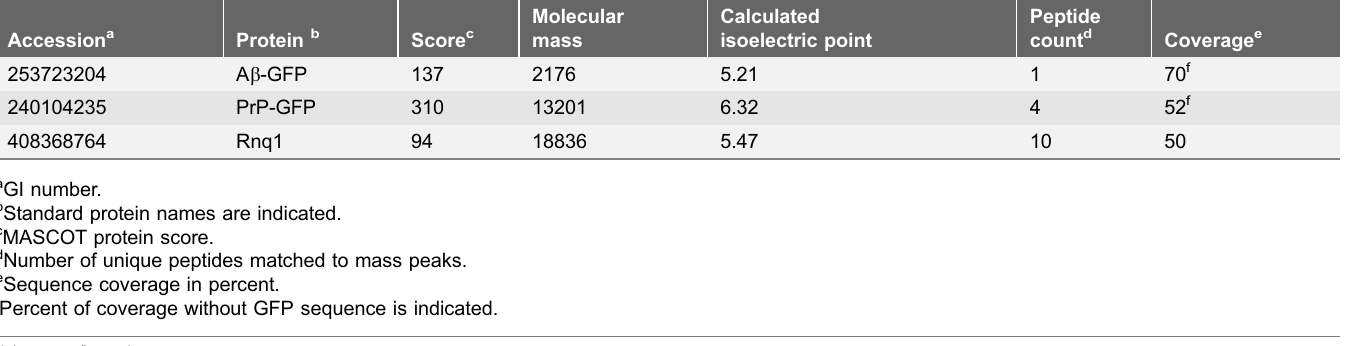
Table 2. Identification of proteins in sarkosyl-treated DRAFs isolated from the BY4742 [ PIN + ] strain expressing A b -GFP or PrP-GFP. Accession a